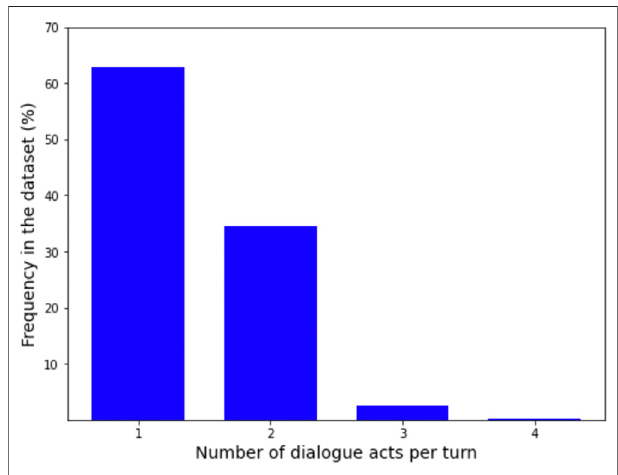
FIGURE 11 | Distribution of number of dialogue acts per turn in CROWDSS.